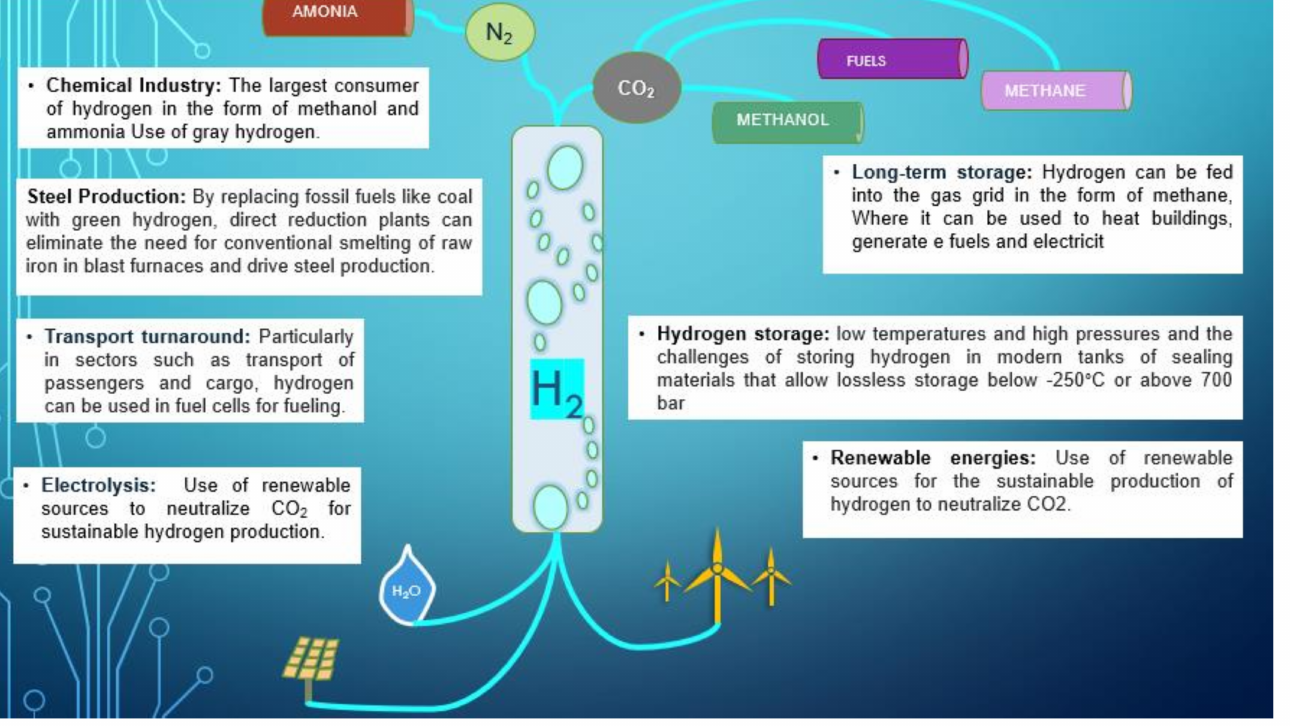
Figure 3. Possible applications and use of